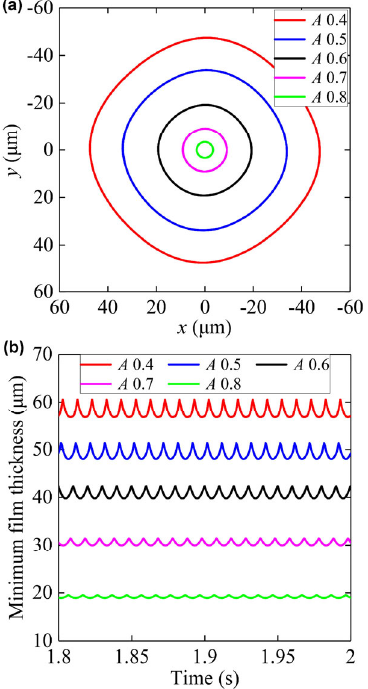
Fig. 3 (a) Journal center orbits and (b) dynamic minimum film thicknesses of a TPJB without static loads for different preload factors.